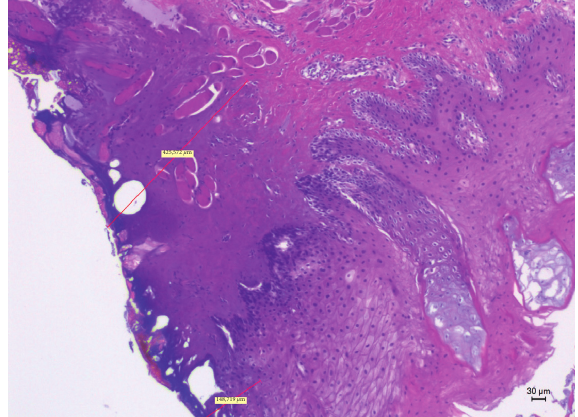
Figure 6: The histological specimen obtained using 6 W in CW with colour EE at 10x magnification (group C).